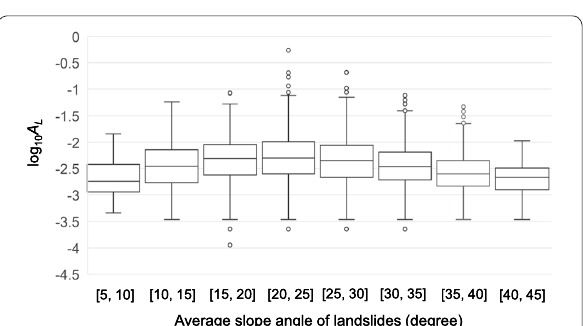
Fig. 12 Box plots of the logarithm of landslide area ( A L , km 2 ) with average landslide slope angle. The interquartile range is represented by the box. Upper whiskers are maximum values 1.5 times the ≤ interquartile range from the top of the box. Lower whiskers are minimum values 1.5 times the interquartile range from the bottom ≥ of the box. Outliers are plotted as dots. The horizontal line represents the median landslide